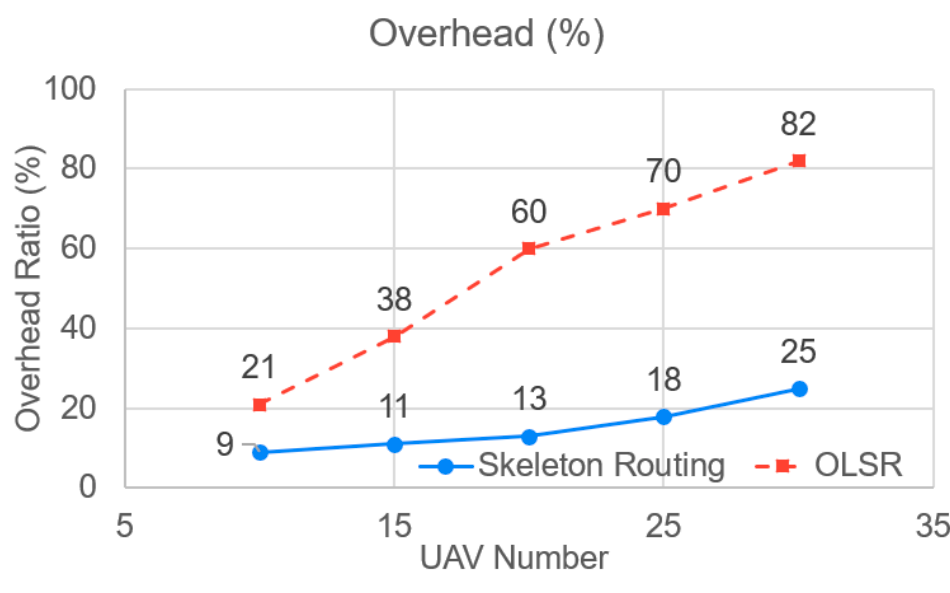
Figure 21. Overhead results with varying network sizes.